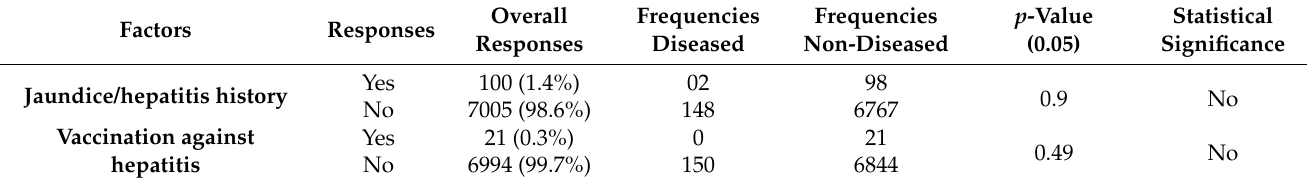
Table 7. Assessment of associated risk factors with hepatitis B spread among the studied